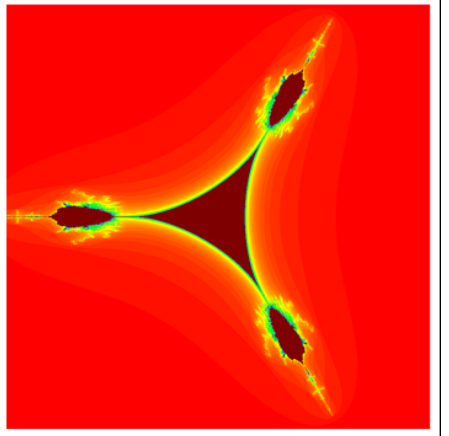
Figure 47. Tricorn via F-iteration with image visual time = 45.6 s.